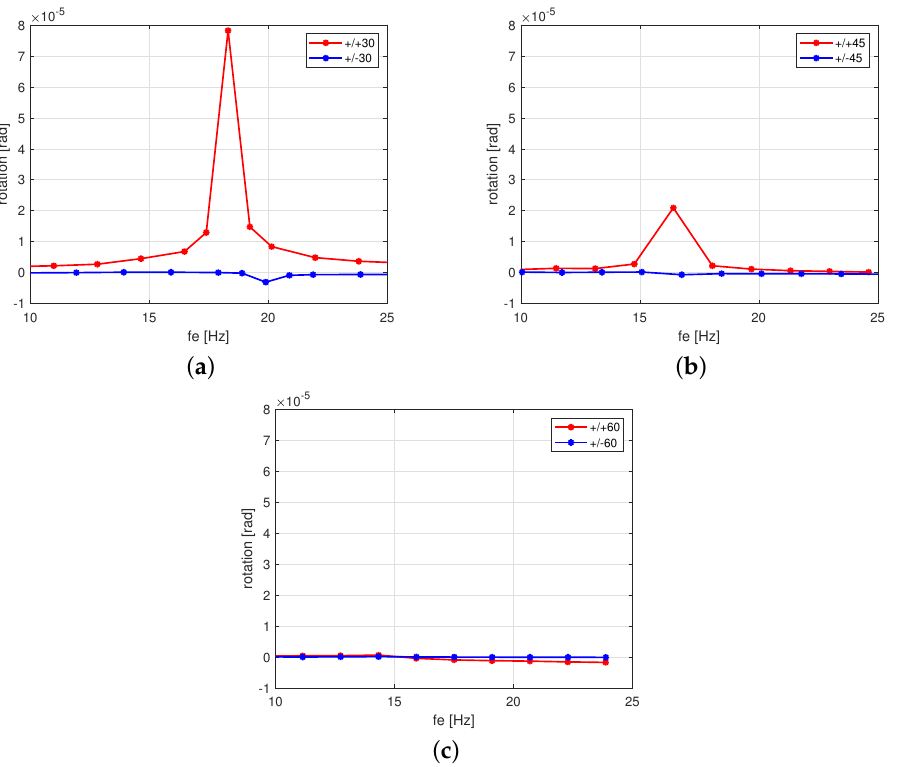
Figure 4. Response of rotation versus excitation frequency f e at A exc = 1 mm for fiber orientations 30 ◦ ( a ), 45 ◦ ( b ), and ( c ) 60 ◦ ,